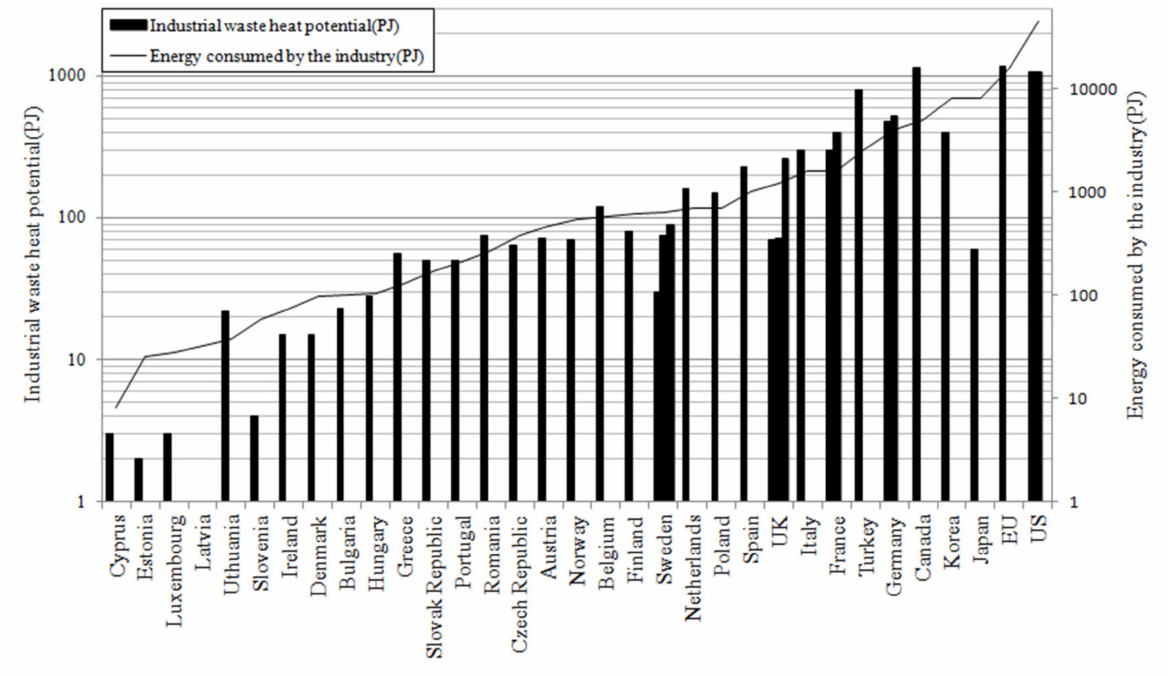
Figure 10. The relation of the industrial waste heat potential (left axis) and the energy consumed by the industry (right